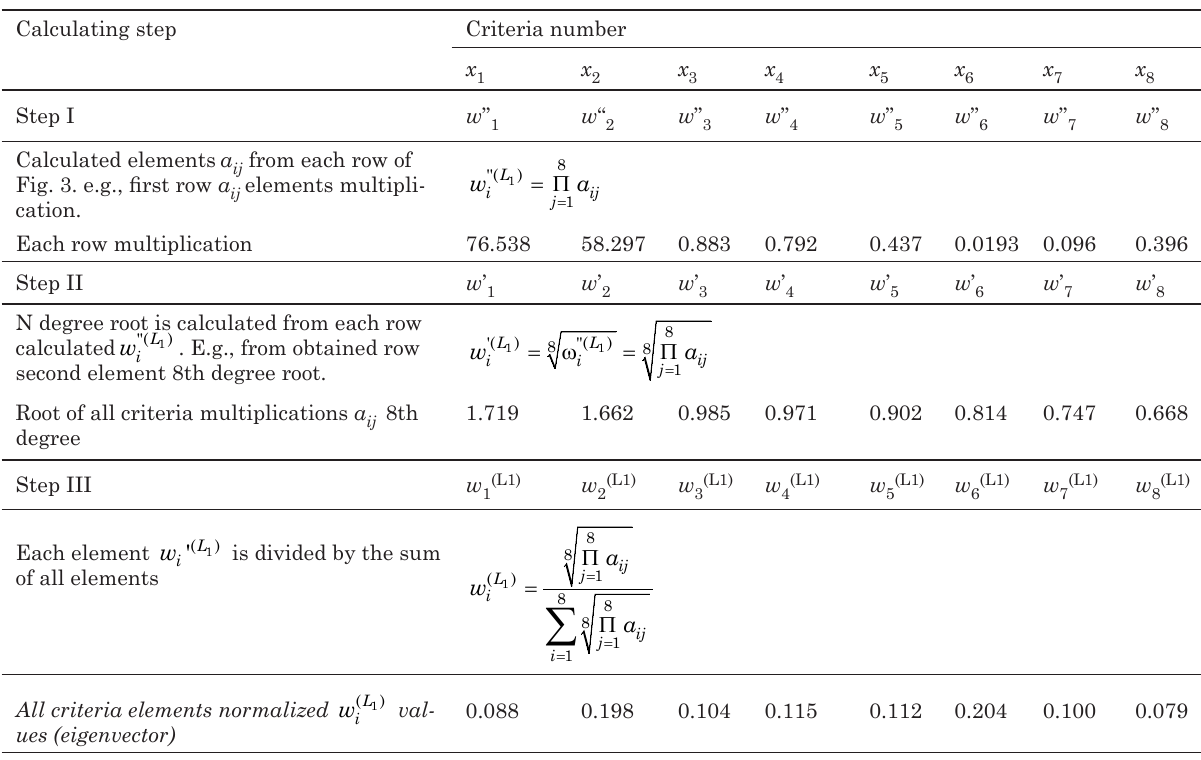
Table 4. Calculation sequence and results of eigenvector